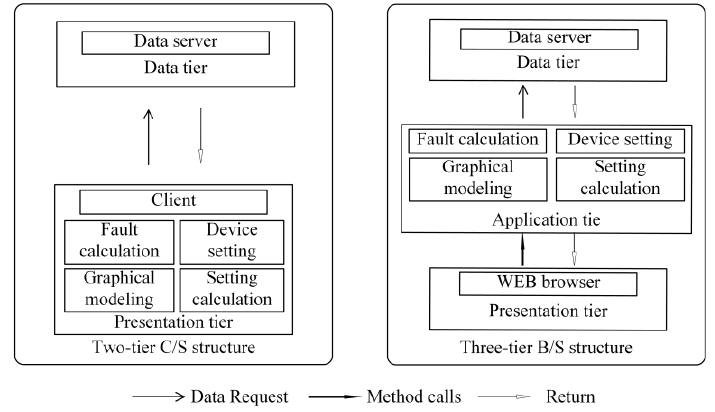
Figure 1. Architecture comparison diagram.